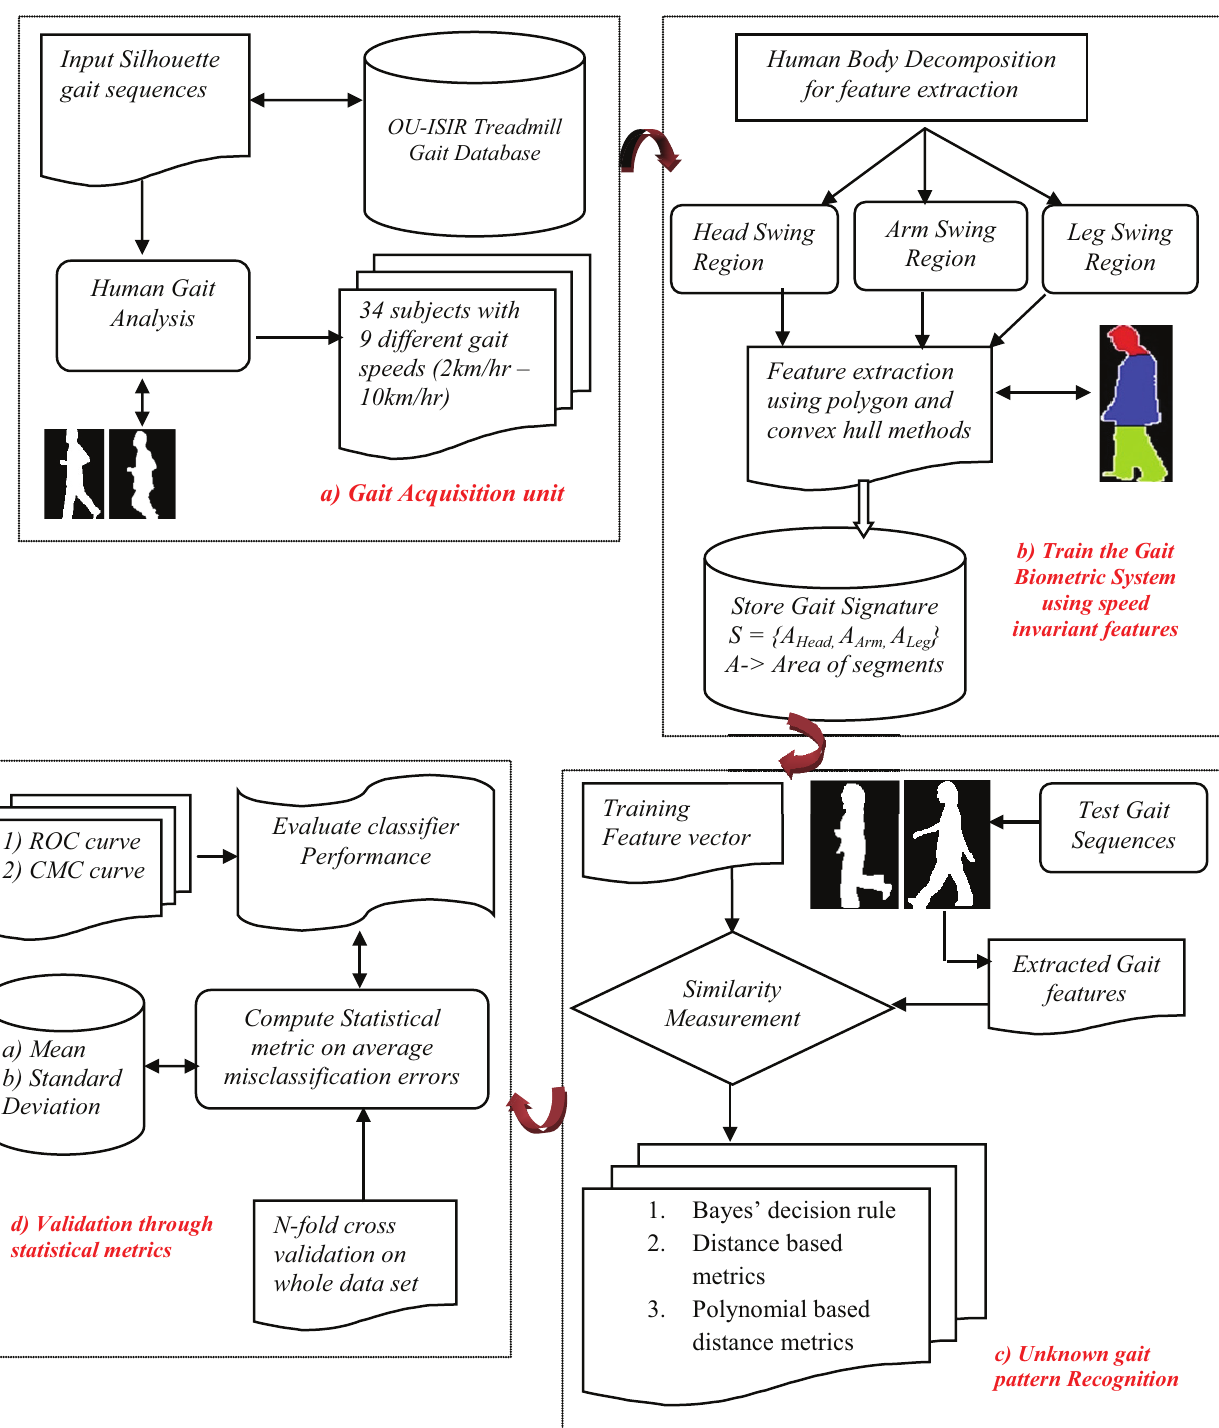
Fig.2. Process Model for Gait Identification